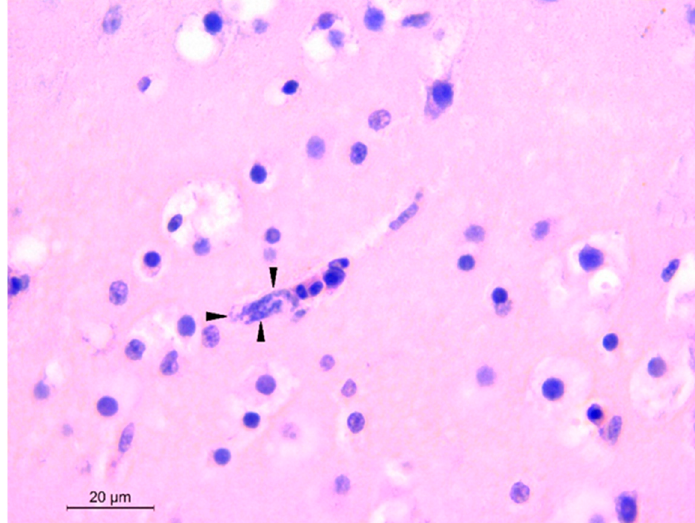
Figure 1. Brain. Agapornis roseicollis . Histological section of brain with an intracapillary schizonts (arrows head) containing multiple small basophilic structures (merozoites). Hematoxylin-eosin.